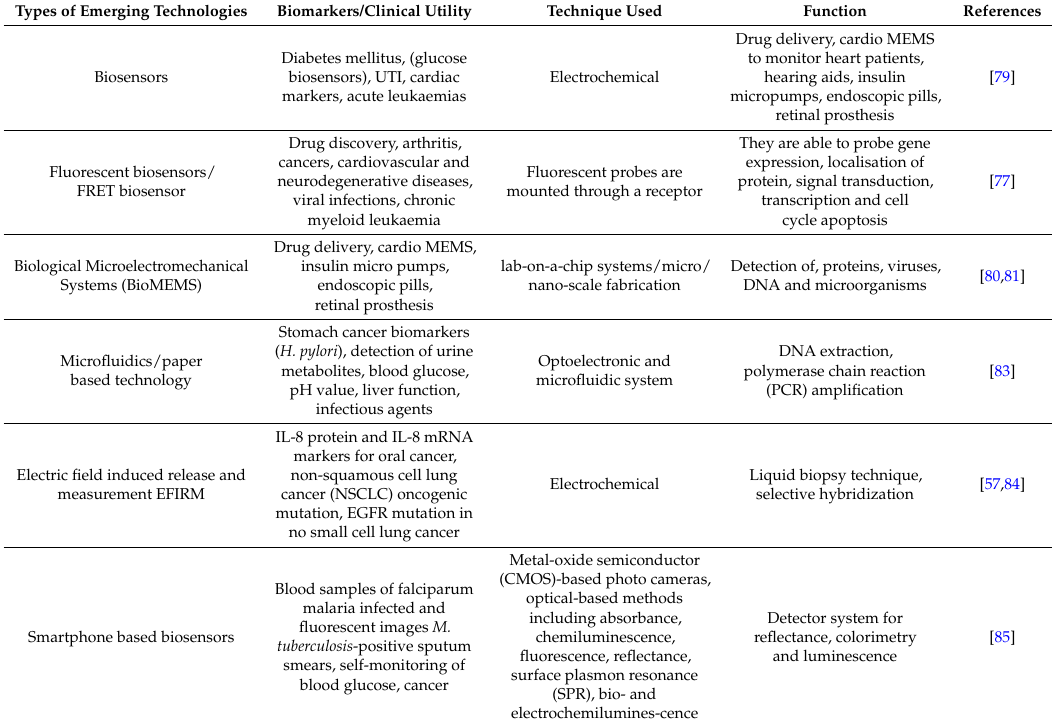
Table 4. Variety of emerging PoC technologies and their clinical utility and